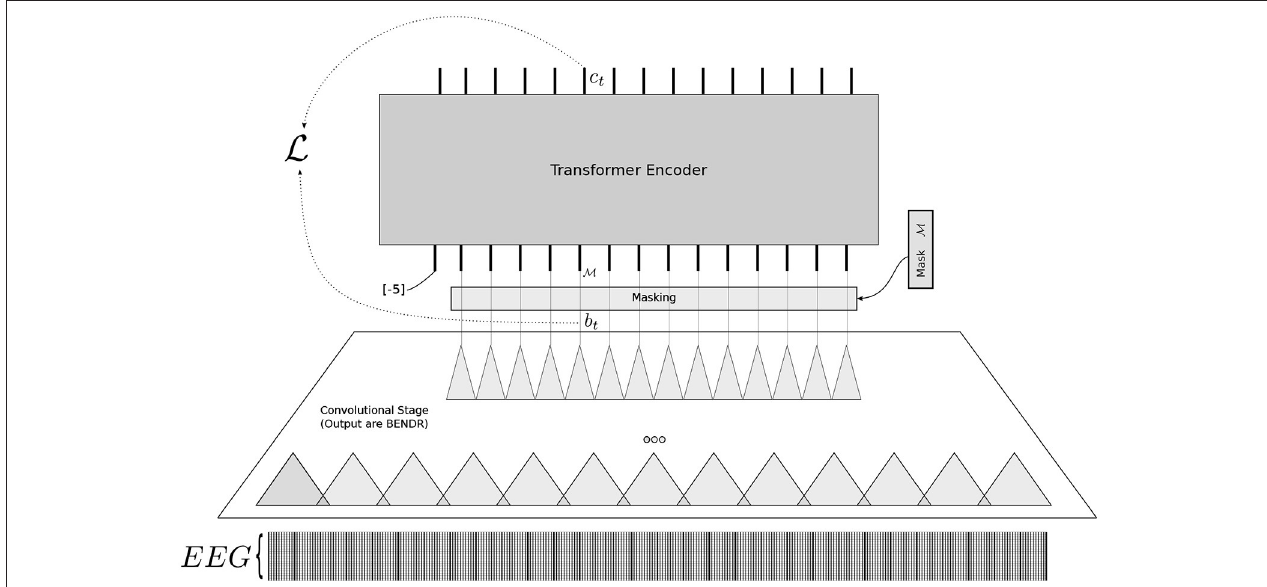
FIGURE 1 | The overall architecture used to construct BENDR. Loss L is calculated for a masked BErt-inspired Neural Data Representations (BENDR) b t (after masking, it is replaced by the learned mask M ), itself produced from the original raw EEG (bottom) via a progression of convolution stages. The transformer encoder attempts to produce c t to be more similar to b t (despite that it is masked) than it is to a random sampling of over BENDR.